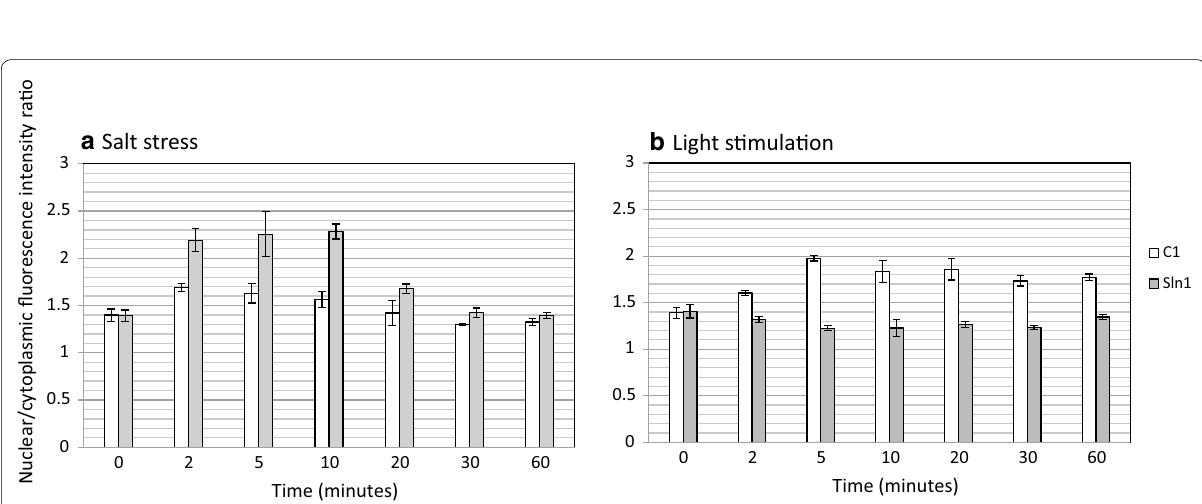
Fig. 5 Nucleo-cytoplasmic redistribution of the HOG1::GFP fusion protein after a salt stress ( a ) and after illumination of the cells ( b ). The salt stress ( a ) was applied by addition of 0.4 M NaCl (final concentration) to the cell suspension. In b the results are shown of exposure of the cell suspension to blue light (200 μE incident intensity, 450 nm LED light). Samples were taken 0, 2, 5, 10, 20, 30 and 60 min after initiation of the experiment. White bars represent the yeast strain with the C1 histidine kinase fusion protein, and grey bars represent the yeast strain with the native Sln1 histidine kinase. Error bars represent the standard deviation calculated from three independent